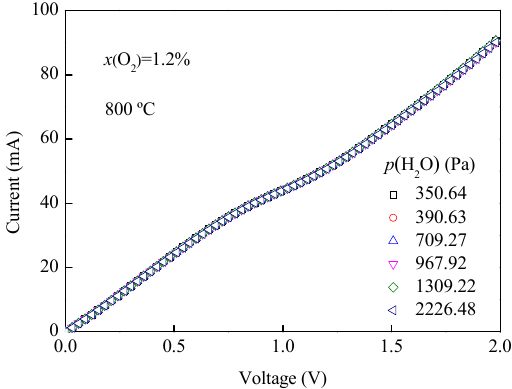
Figure 9. The log ( I L · T ) and 1000 / T in x (O 2 ) of 2.5%.